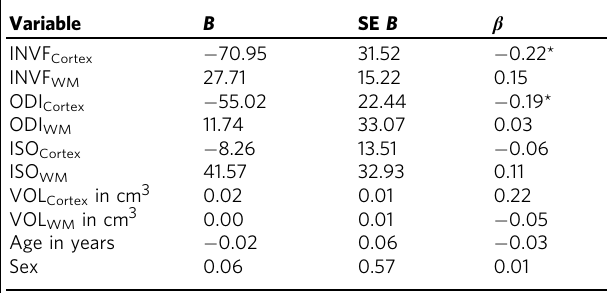
Table 1 Summary of multiple regression analysis for